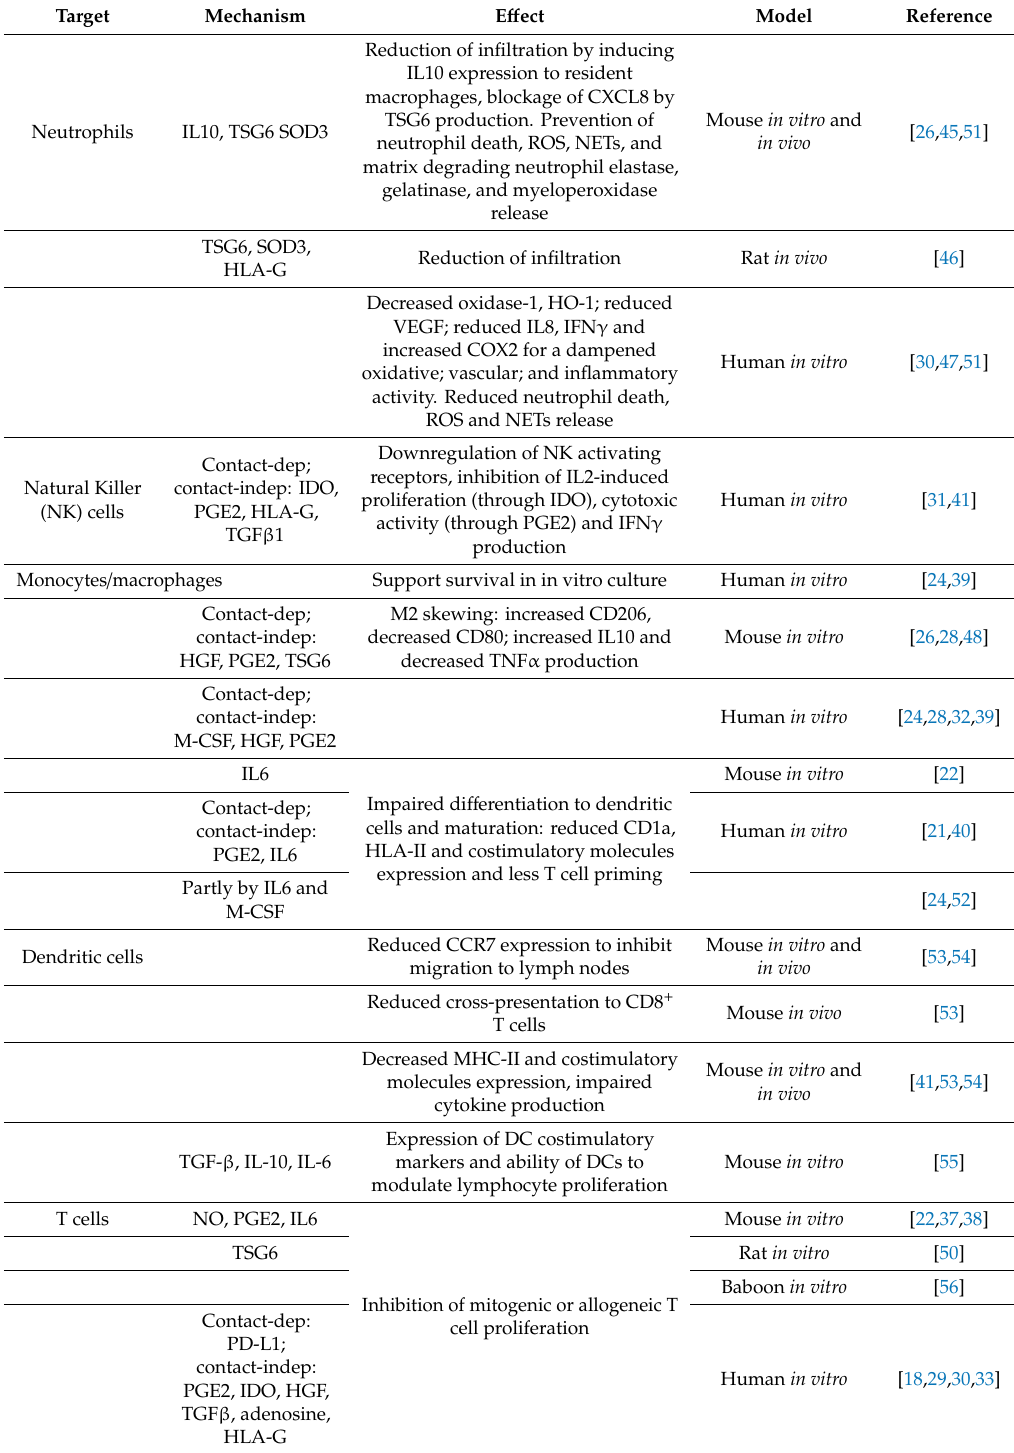
Table 2. MSC-driven e ff ects on immune cell targets. The e ff ects on immune cell targets of MSC are listed, with the corresponding mechanism of action in the cases it was